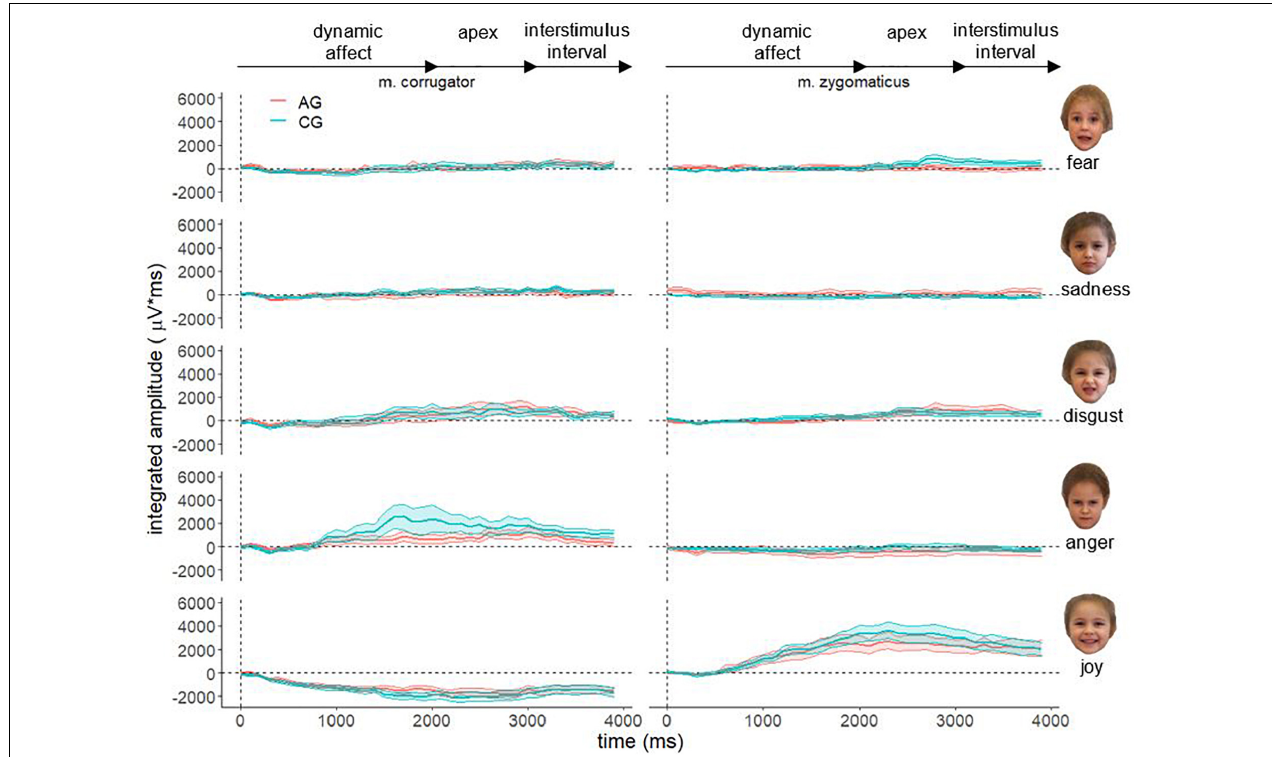
FIGURE 4 | Electromyographical activity [ µ V integrated over 40 × 100 ms interval ( µ V × ms)] of corrugator supercilii (m. corrugator) and zygomaticus major (m. zygomaticus) for AG (red line) and CG (blue line) in response to video clips of affect expressing faces of adults for all basic affects. Measurement period 0–4000 ms, vertical dotted line represents stimulus onset; ribbons represent the standard error.